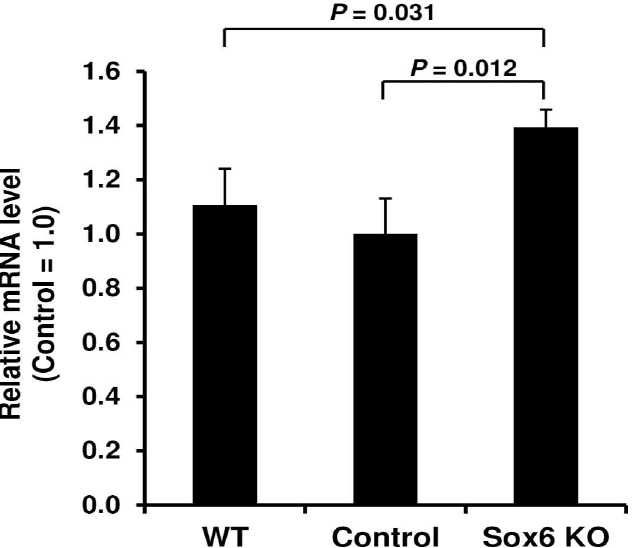
Fig 2. Cyclin D1 is upregulated in the Sox6 KO heart at postnatal day 7. Total RNA was extracted from ventriclesof wild type (WT), control and Sox6 KO mice at postnatalday 7 (P7), and the mRNA level of cyclin D1 ( Ccnd1 )was quantified by RT-qPCR. Data are normalized for those from control mice and representedas mean ± s.d. ( n =